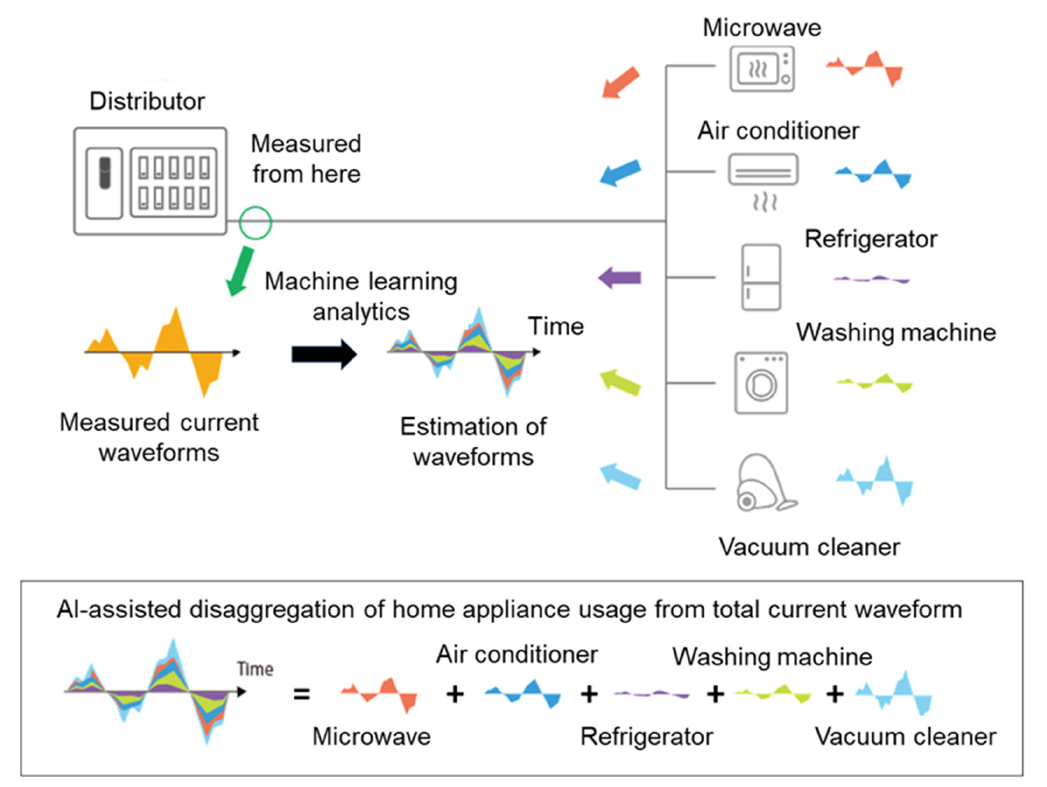
Figure 1. Schematic of NILM technology. NILM technology used in the present study requires only a single sensor installed on the power distribution board, which collects aggregated power consumption data from various appliances, and then analyzes the data using Machine Learning algorithms to produce estimated disaggregation into major home appliance usage from the total current waveform regardless of the manufacturer or model of the home appliance.